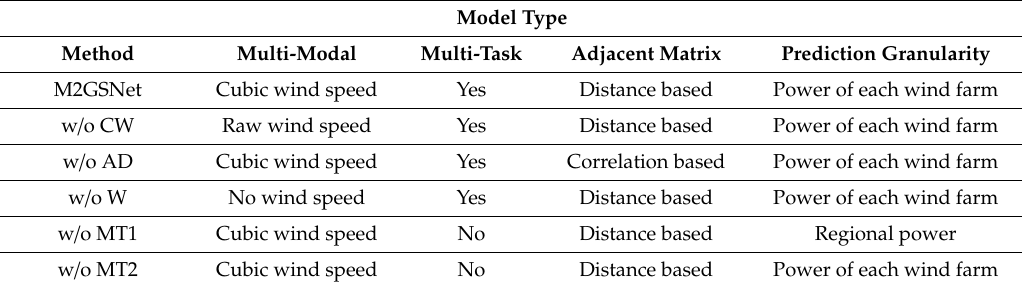
Table 1. The structure of di ff erent M2GSNet